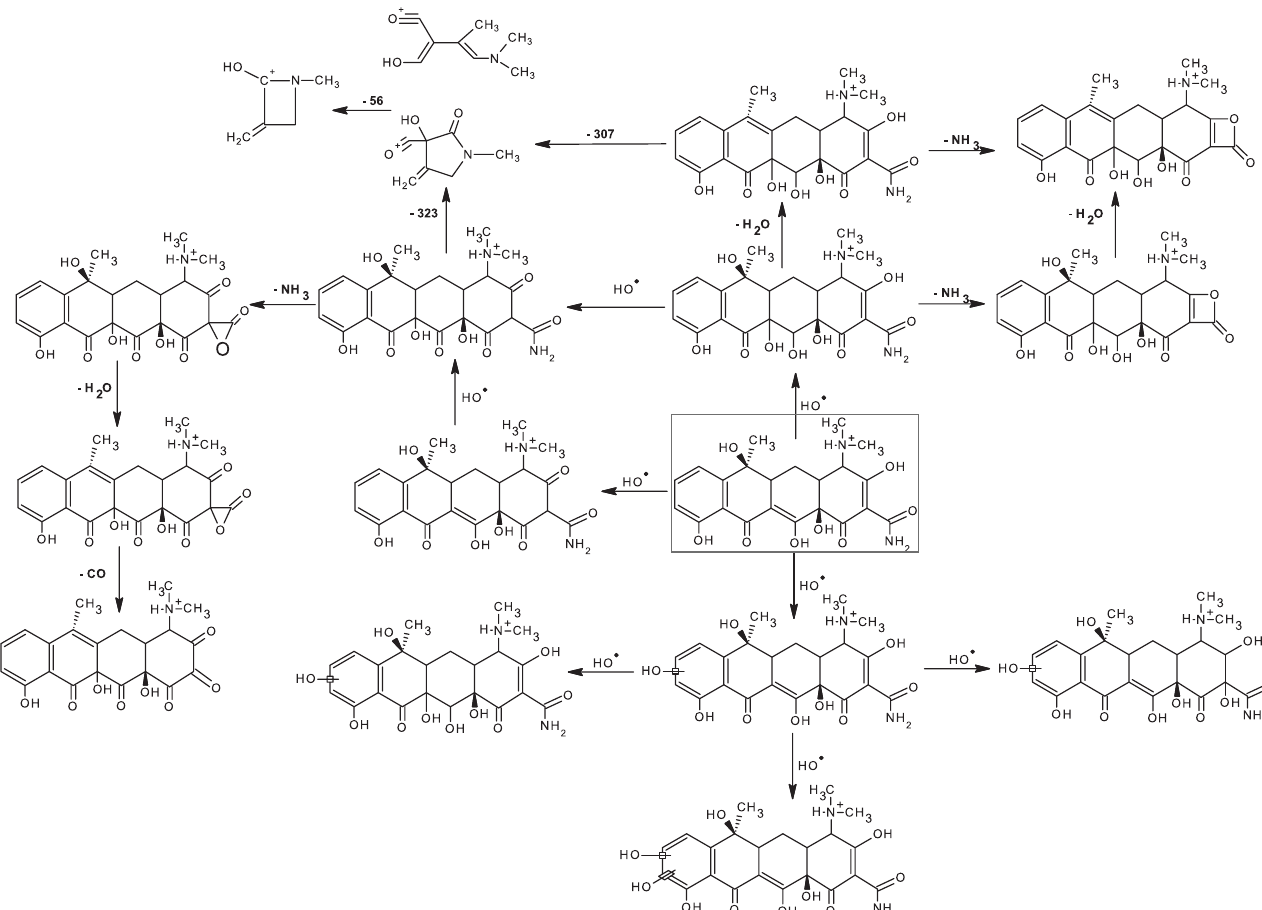
FIGURE 4 - Products of photocatalytic degradation of tetracycline (Adapted from Mboula et al .,